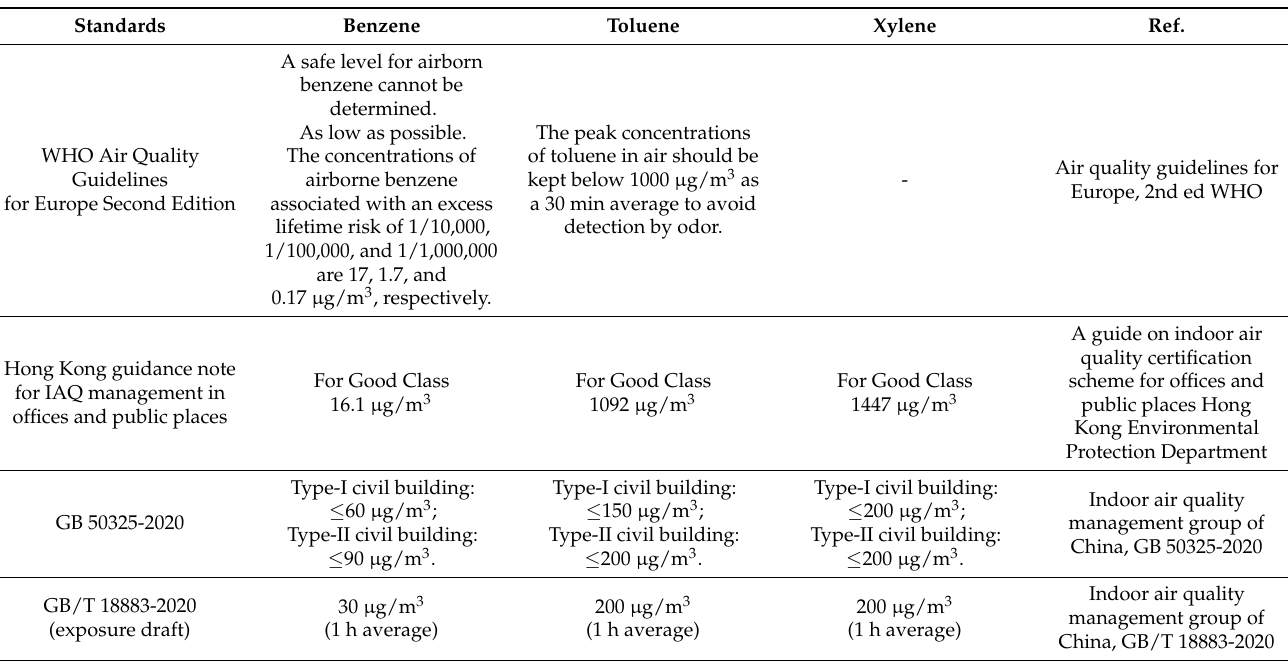
Table 1. Concentration limits of BTX in indoor air according to different